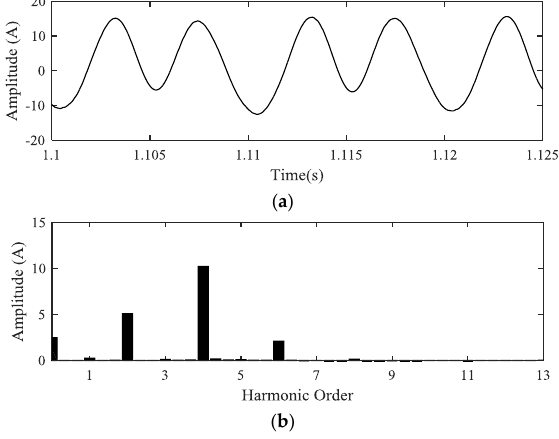
Figure 4. ( a ) Reactive power circulating current waveform; ( b ) Frequency spectrum.